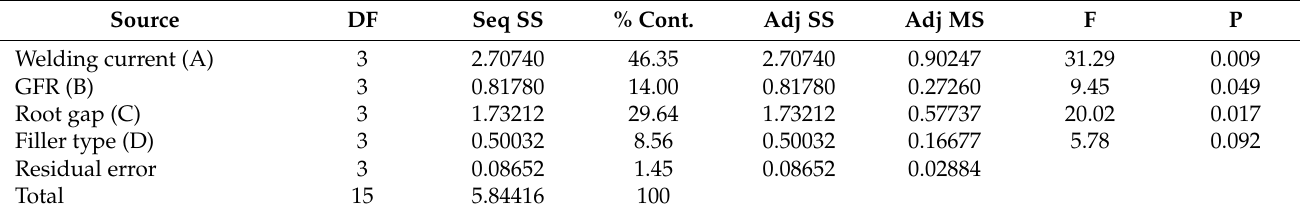
Table 22. Analysis of variance (ANOVA) of Bead Widths.